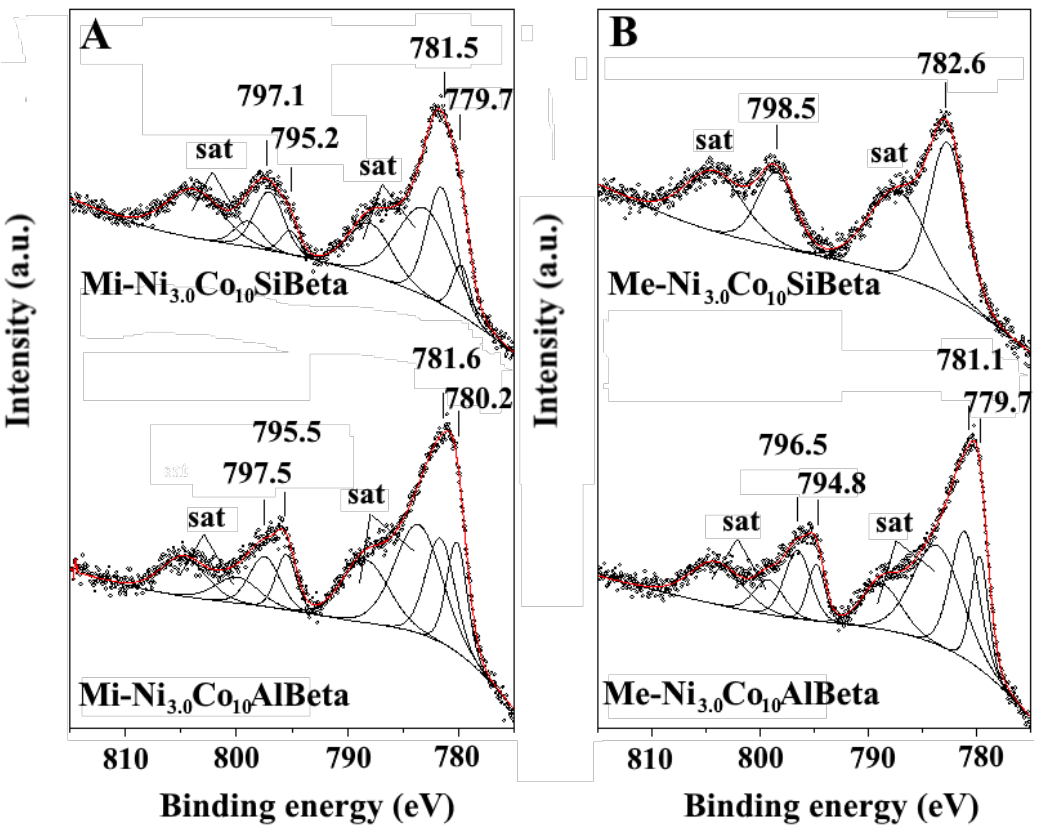
Figure 3. Co 2p XPS spectra of ( A ) Mi-Ni 3.0 Co 10 SiBeta and Mi-Ni 3.0 Co 10 AlBeta and ( B ) Me-Ni 3.0 Co 10 SiBeta and Me-Ni 3.0 Co 10 AlBeta.